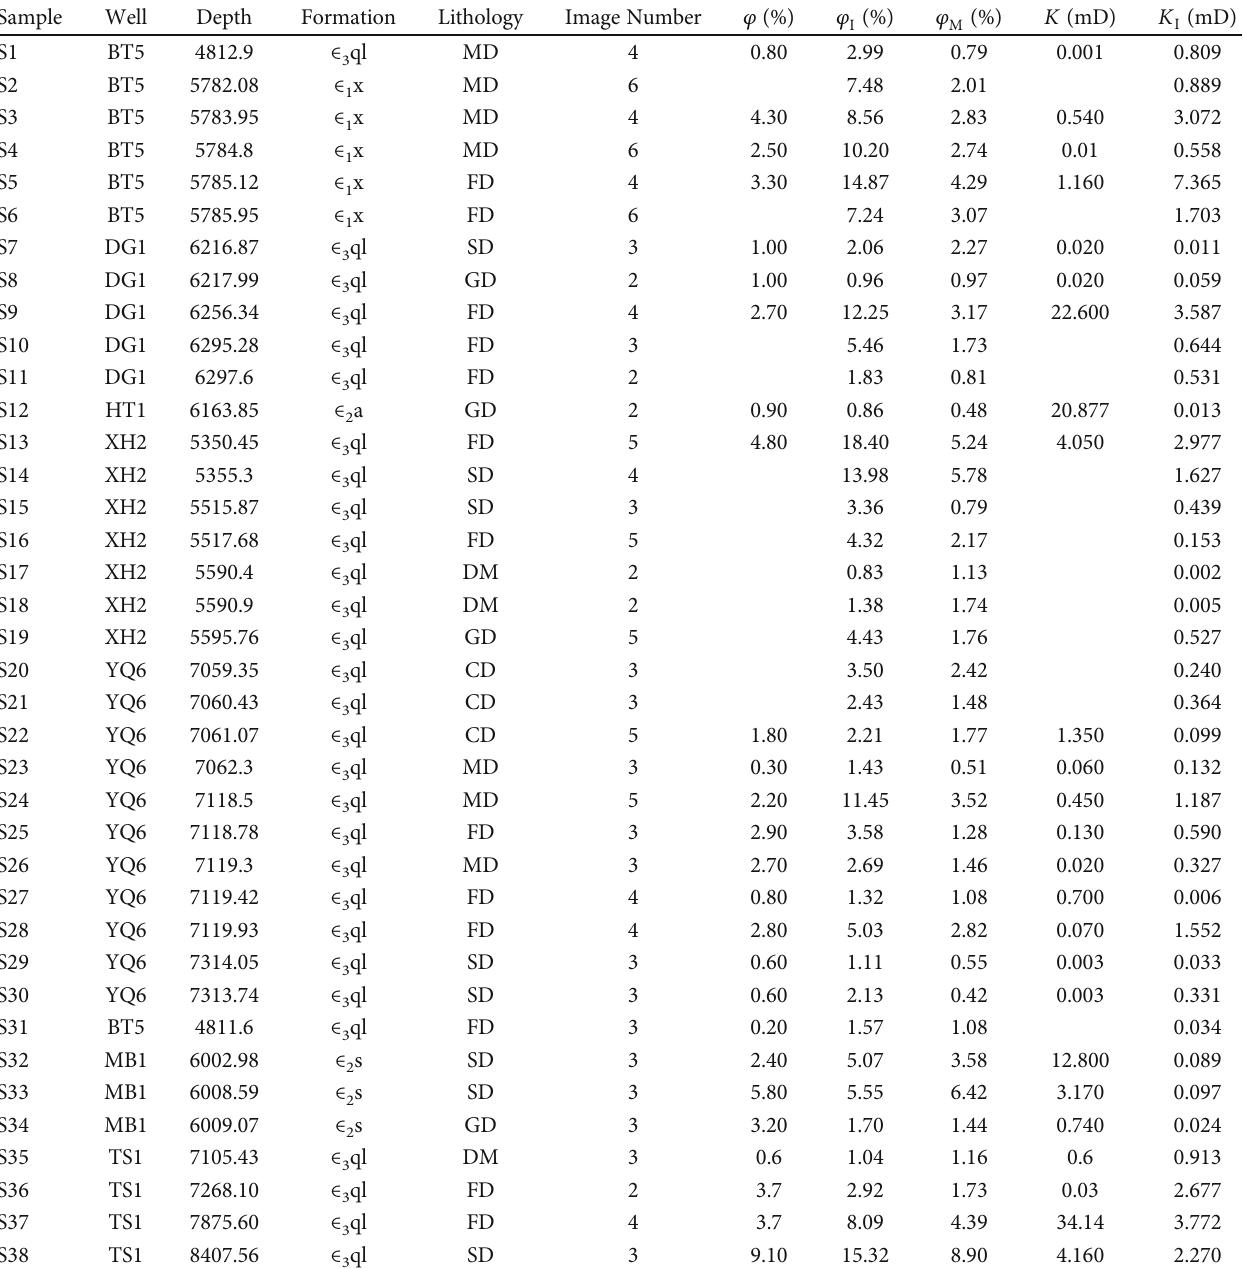
Table 1: Basic information, petrophysical data from helium porosimetry, and image analysis of samples in the study. Sample Well